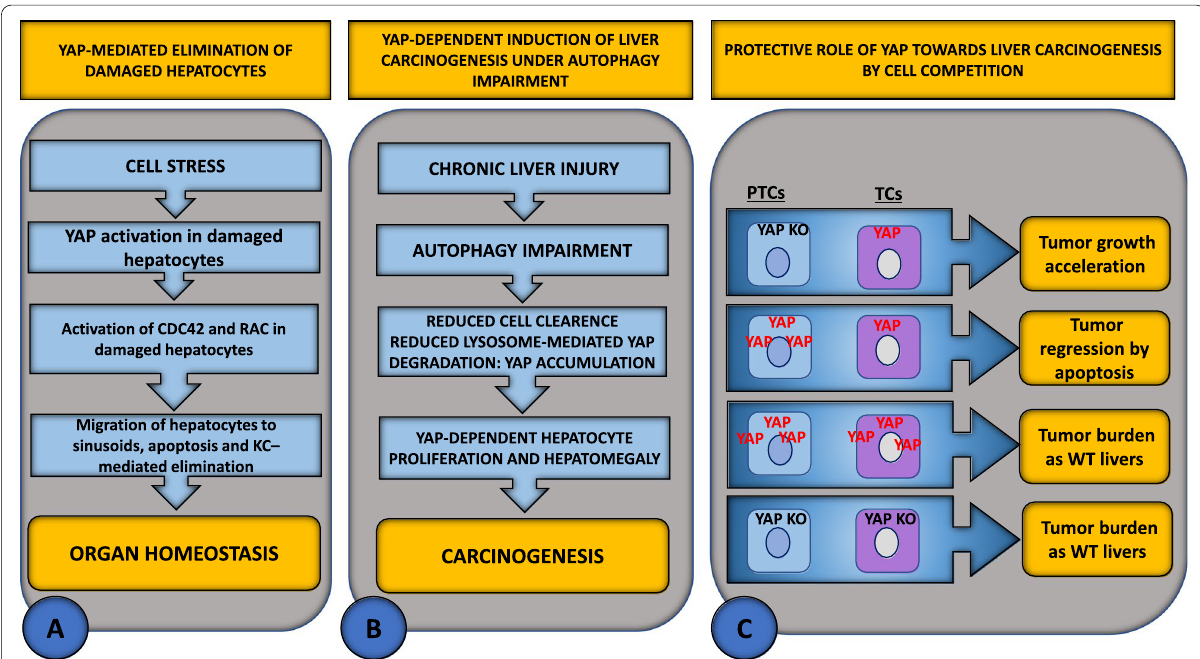
Fig. 6 Schematic representation of YAP-mediated modulation of liver carcinogenesis. A Activation of YAP in damaged hepatocytes protects against liver carcinogenesis by activating the GTPases RAC and CDC42, which regulate cytoskeletal organization. Activation of CDC42 and Rac drives migration of damaged hepatocytes to sinusoids, where they are eliminated by KCs. B YAP acts as a trigger of liver carcinogenesis under the condition of impaired autophagy, which affects cell clearance leading to accumulation of YAP due to decreased lysosomal-mediated degradation of YAP. C A mechanism of tumor suppression by YAP and TAZ based on a competitive interaction between tumor cells (TCs) and their environment has been described. Deletion of Yap/Taz in peritumoral cells (PTCs) accelerates tumor growth, whereas its overexpression suppresses tumor growth and can cause tumor regression. When competition is neutralized, e.g., when PTCs and TCs simultaneously overexpress or delete Yap/Taz, the tumor burden is similar to that in WT liver. Thus, tumor cells require YAP/TAZ for survival, but only when surrounded by WT